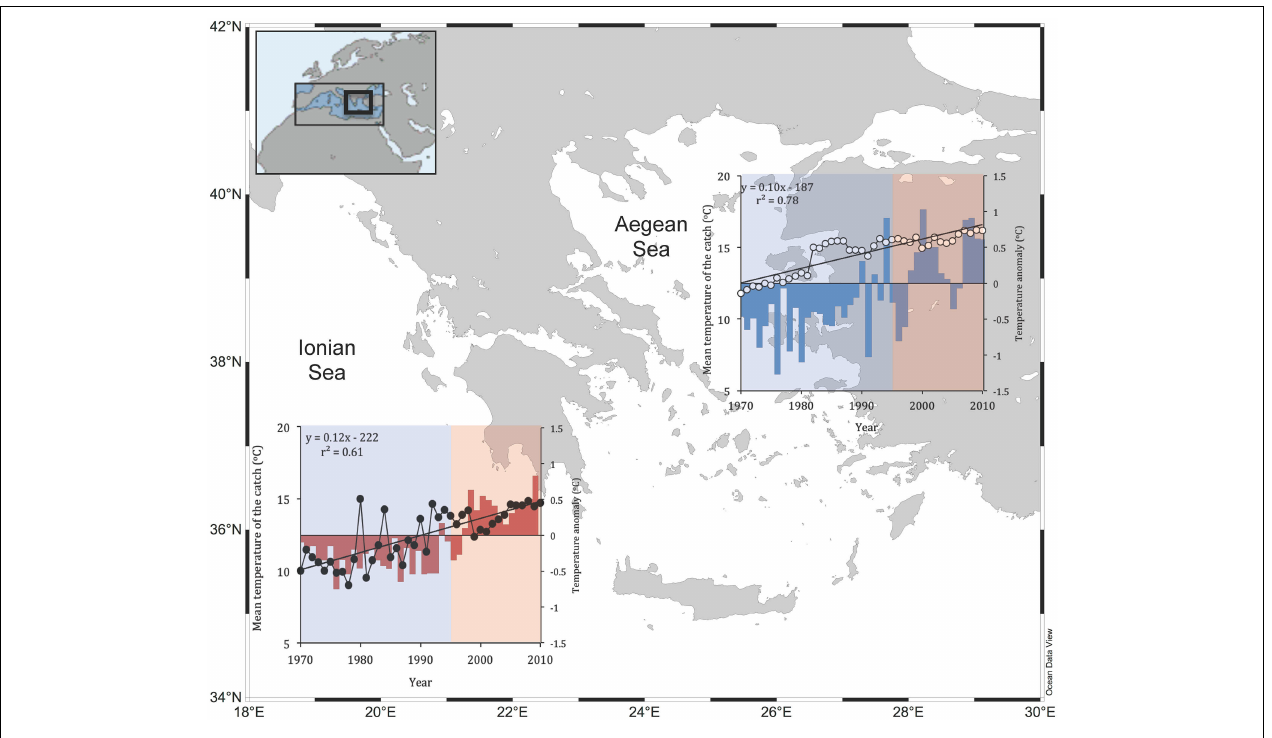
FIGURE 1 | The mean temperature of the catch ( ◦ C; Ionian Sea: black dots; Aegean Sea: white dots) based on official landings and sea surface temperature anomaly ( ◦ C; Ionian Sea: red bars;